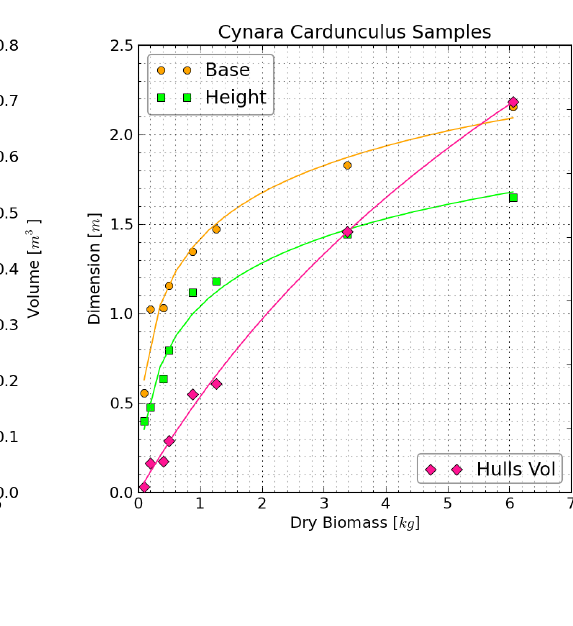
Figure 6. Allometric relations between Kinect-derived dimensions (base and height) and dry biomass measurements. Solid lines represent least squares logarithmic fits of the form y = A + B · log( x + C ) / ( log ( D ) + 1)